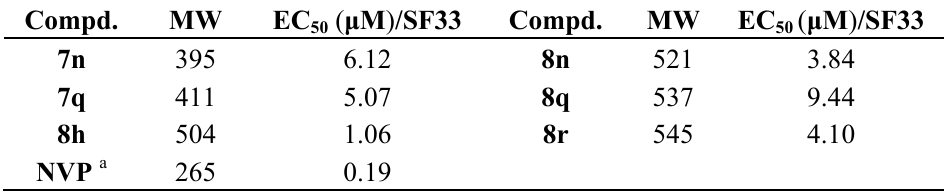
Table 2. Antiviral Activity of Compounds on HIV-1